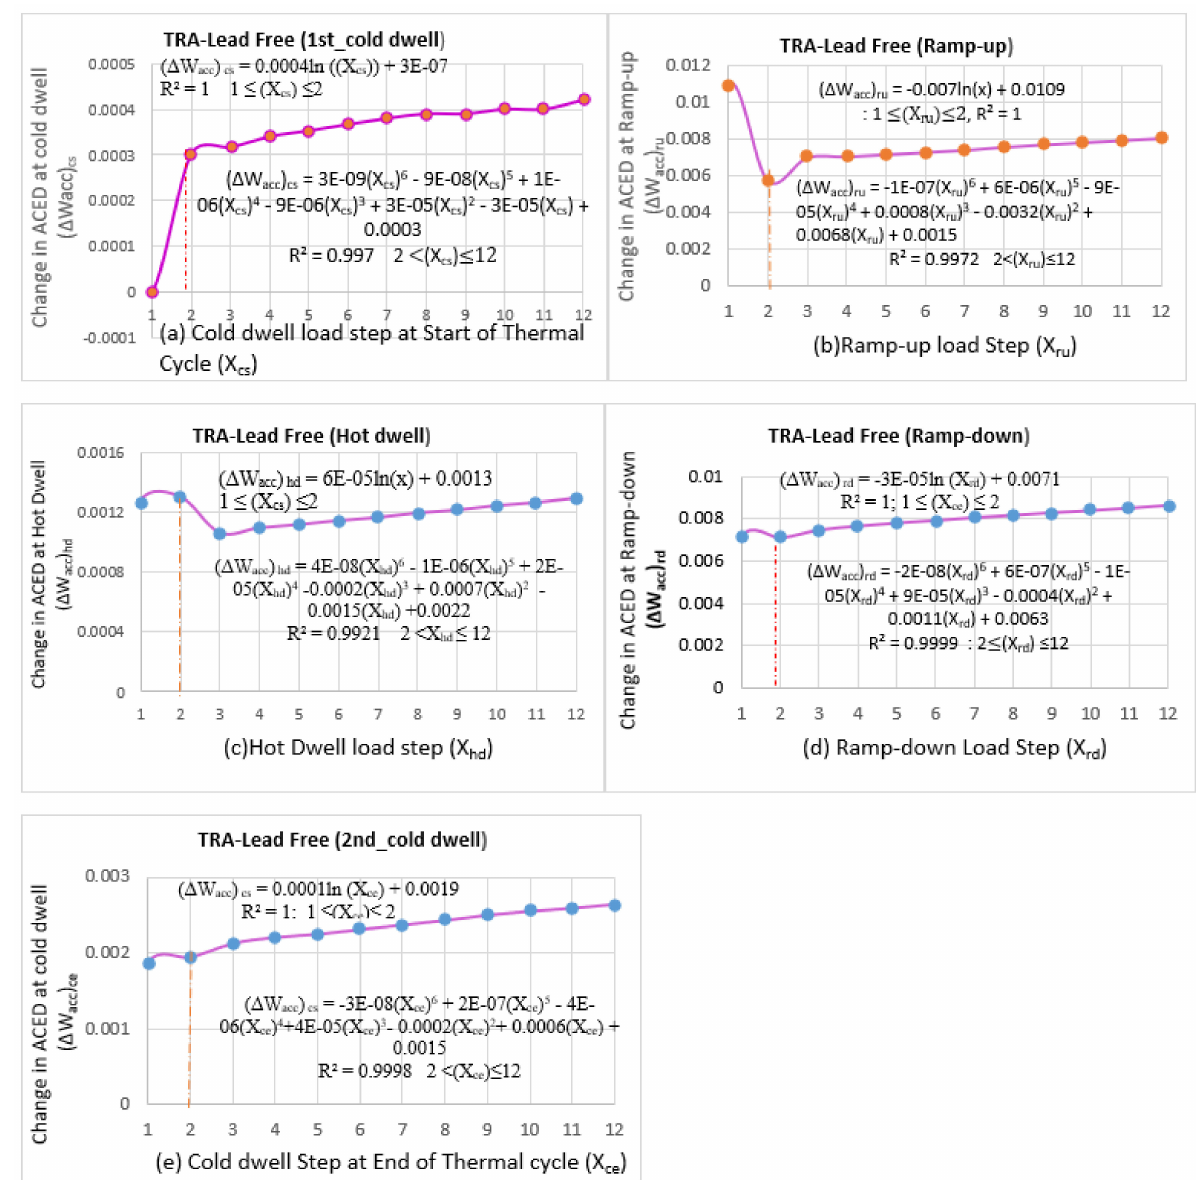
Figure 14. Change in ACED in Pb-free solder ( a ) 1st cold dwell, ( b ) ramp-up, ( c ) hot dwell, ( d ) ramp-down, ( e ) 2nd cold